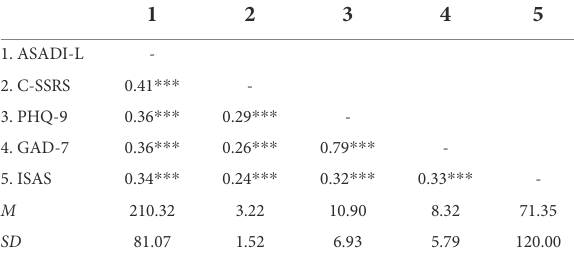
TABLE 4 Correlations among the ASADI-L and suicide-related